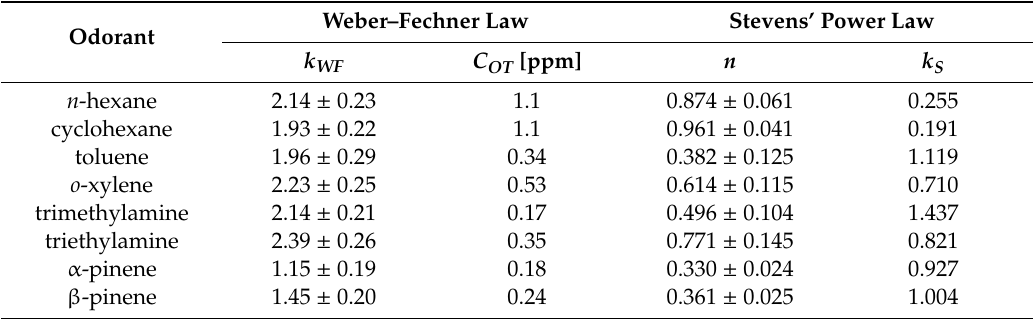
Table 4. Weber–Fechner and Stevens’ law coe ffi cients calculated based on experimental measurements.